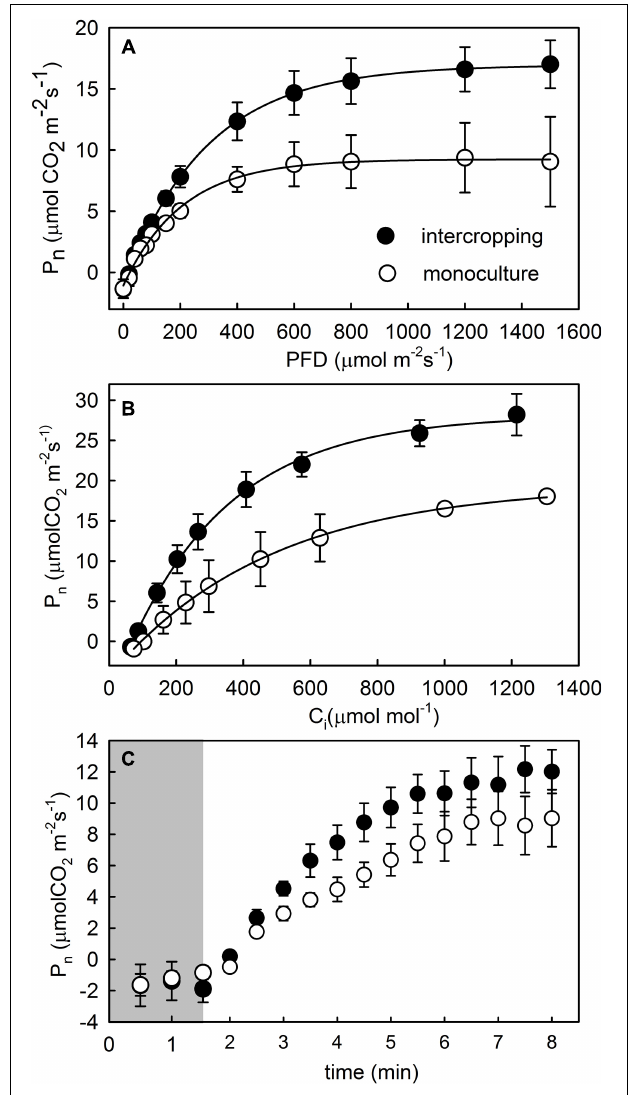
FIGURE 3 | Photosynthetic light response (A) , CO 2 response (B) , and photosynthetic induction (C) curves of fully mature leaves of morphophallus xiei under different cropping system. Each point is the mean ± SD of five replicates. P n , net photosynthesis; PFD, photo flux density; C i , intercellular CO 2 concentration; closed parts of photosynthetic induction curves indicate a response to low light, and open parts indicate a response to high light.